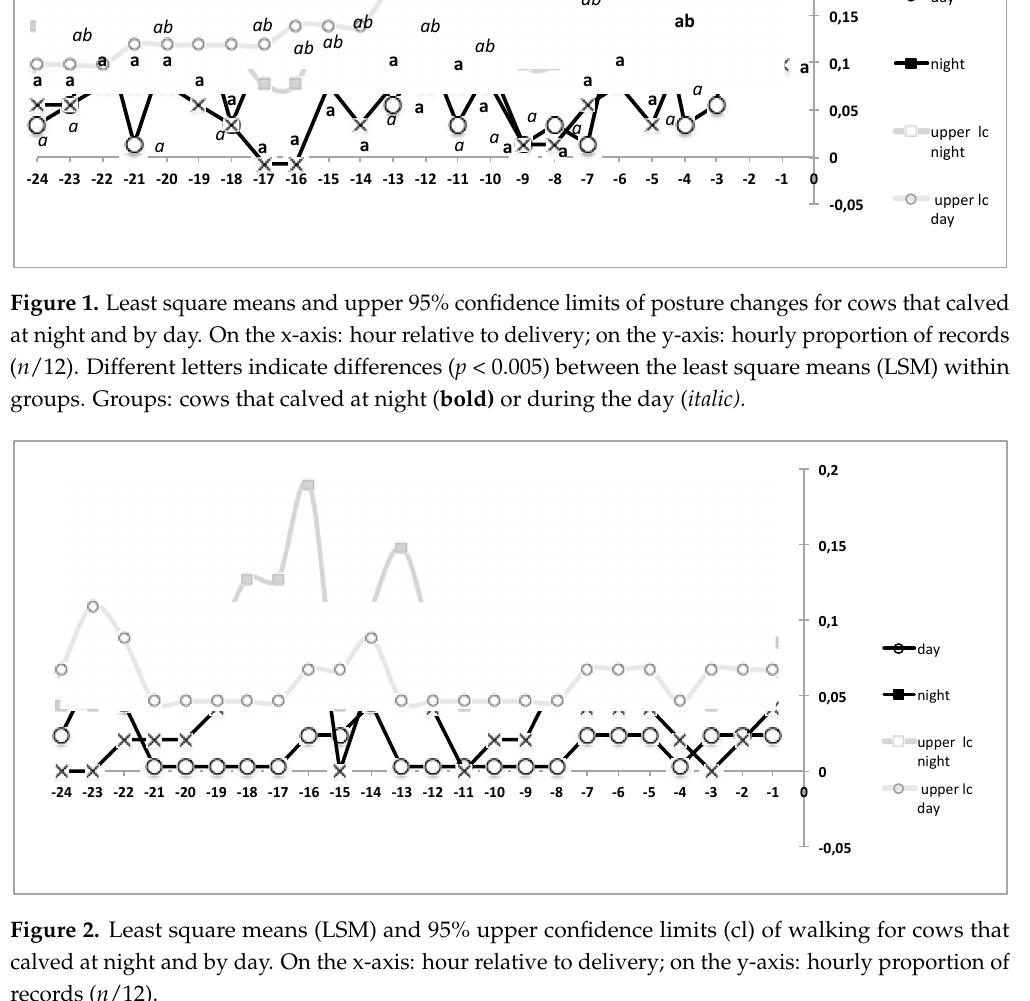
Figure 2. Least square means (LSM) and 95% upper confidence limits (cl) of walking for cows that calved at night and by day. On the x-axis: hour relative to delivery; on the y-axis: hourly proportion of records ( n /12).